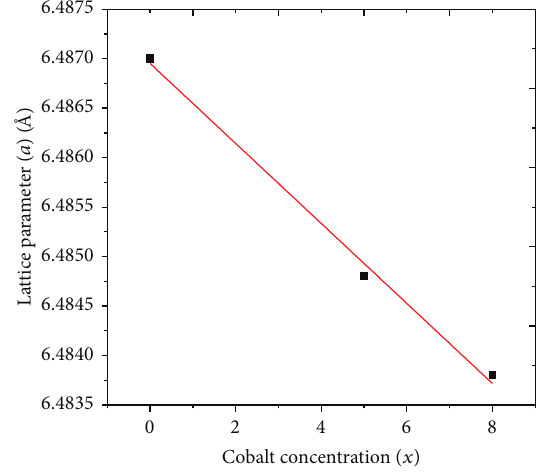
Figure 2: Variation of lattice parameter with increase in Co